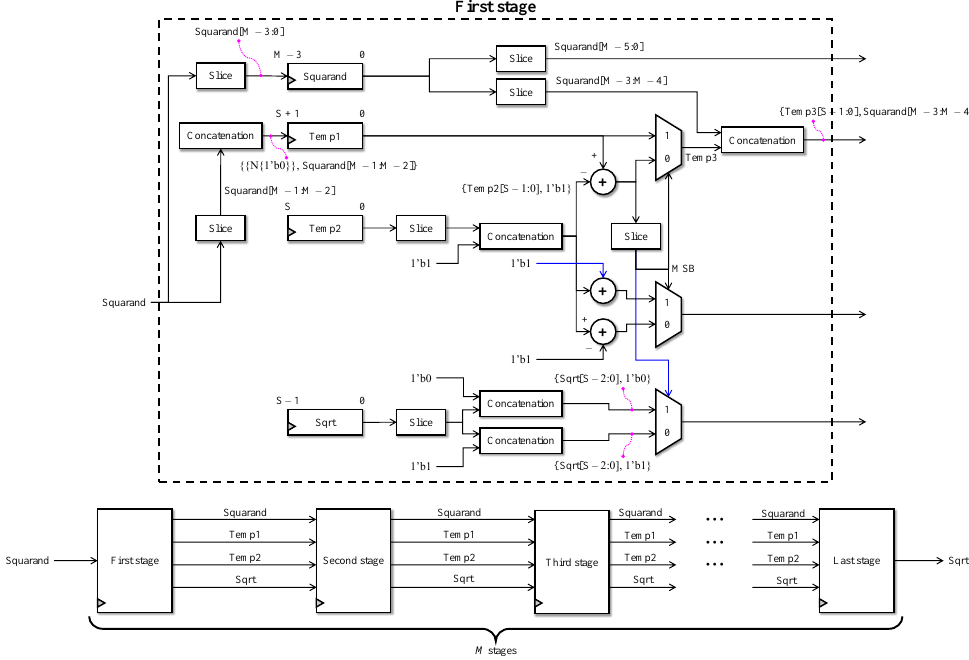
Figure A3. Datapath of the parallel square rooter. Blue arrows are adopted to signify no intersection, and MSB stands for most significant